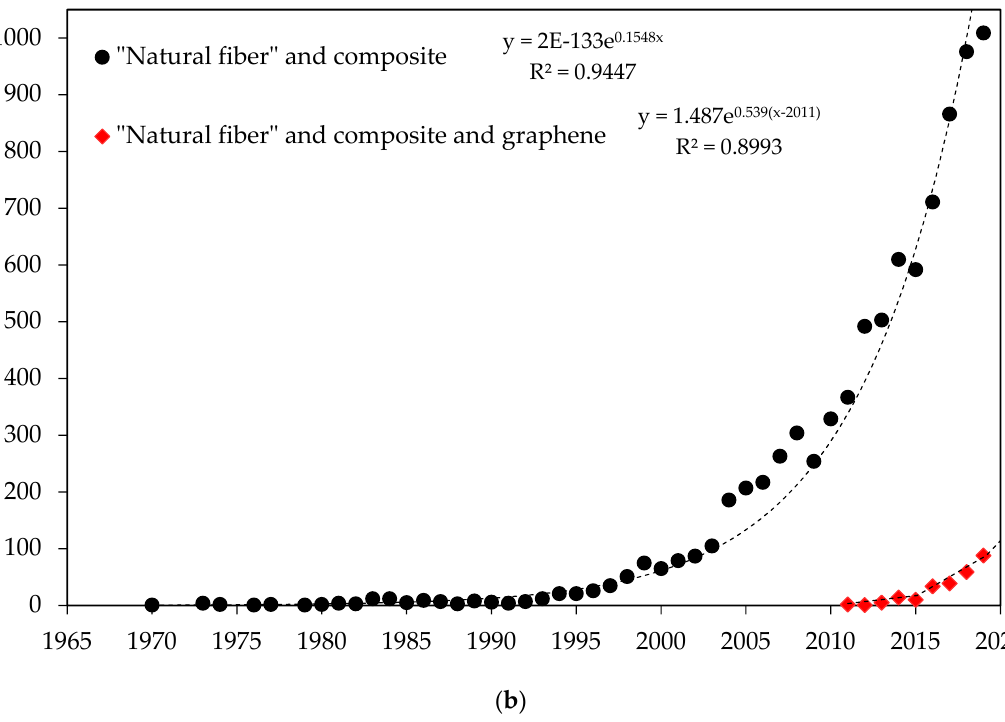
Figure 1. Publications by year for different material classes, according to Scopus database [3]: ( a ) “Composite materials”, “Polymer composites”, and “Polymer composites and fiber”; ( b ) “Natural fiber and composite” and “Natural fiber and composite and graphene”. In corresponding equations, y is the number of publications, and x is the year.